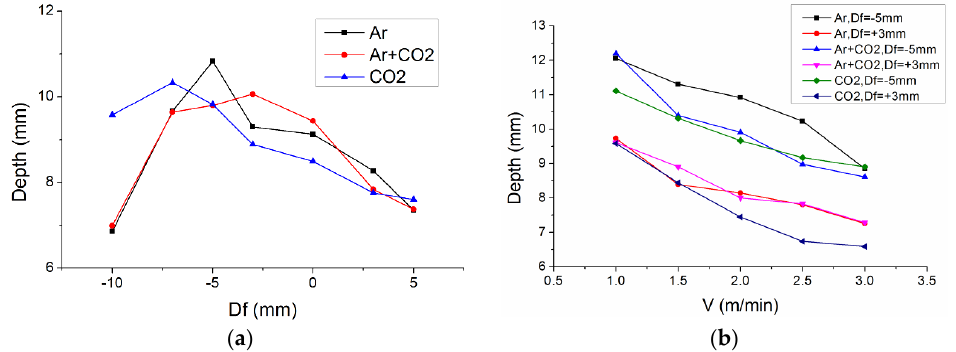
Figure 6. Variation of weld penetration along with different V , Df and shielding gases. ( a ) Under different Df and shielding gases; ( b ) Under different V and shielding gases.